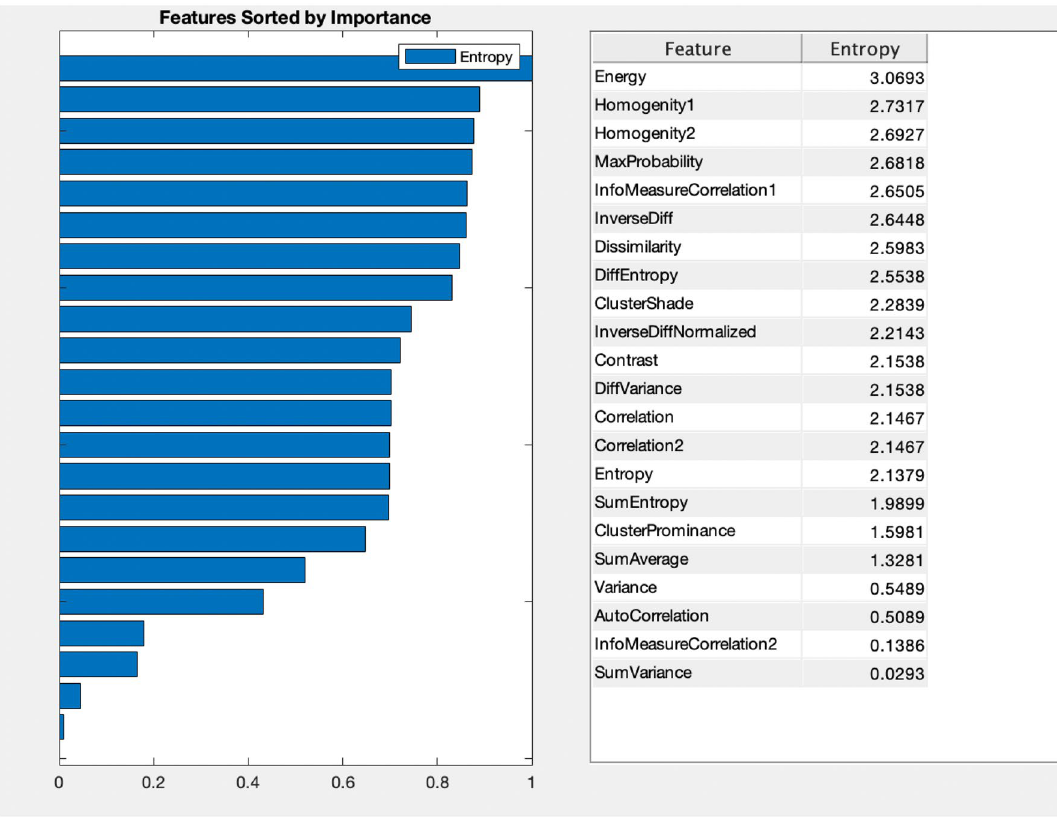
Figure 2. Feature ranking based on entropy